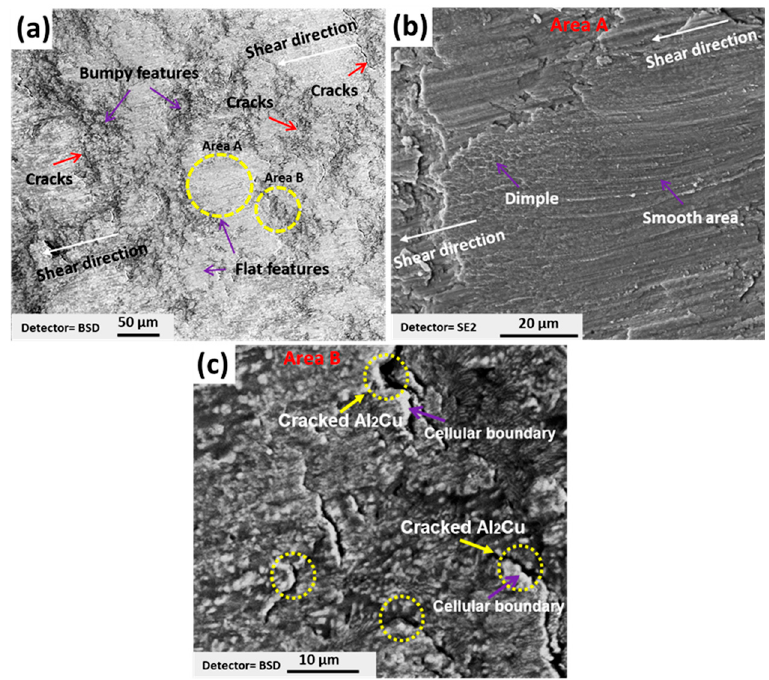
Figure 10. ( a ) SEM backscattered image of fracture surface at low magnification ( b , c ) high-magnified SEM images of areas (A, B) marked by yellow circles in ( a ).